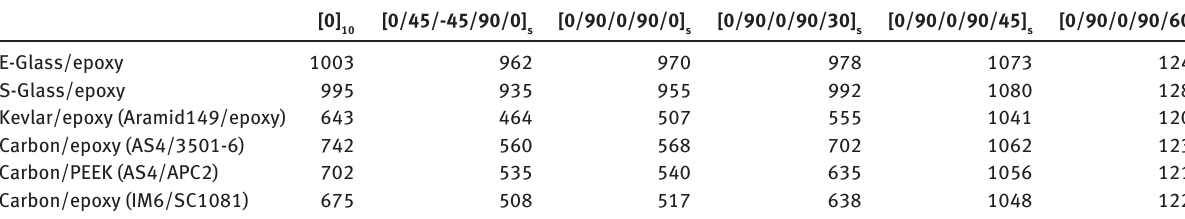
Table 6 Comparison of the critical load P (N) obtained from meshfree methods (nodes: 11 × 23).